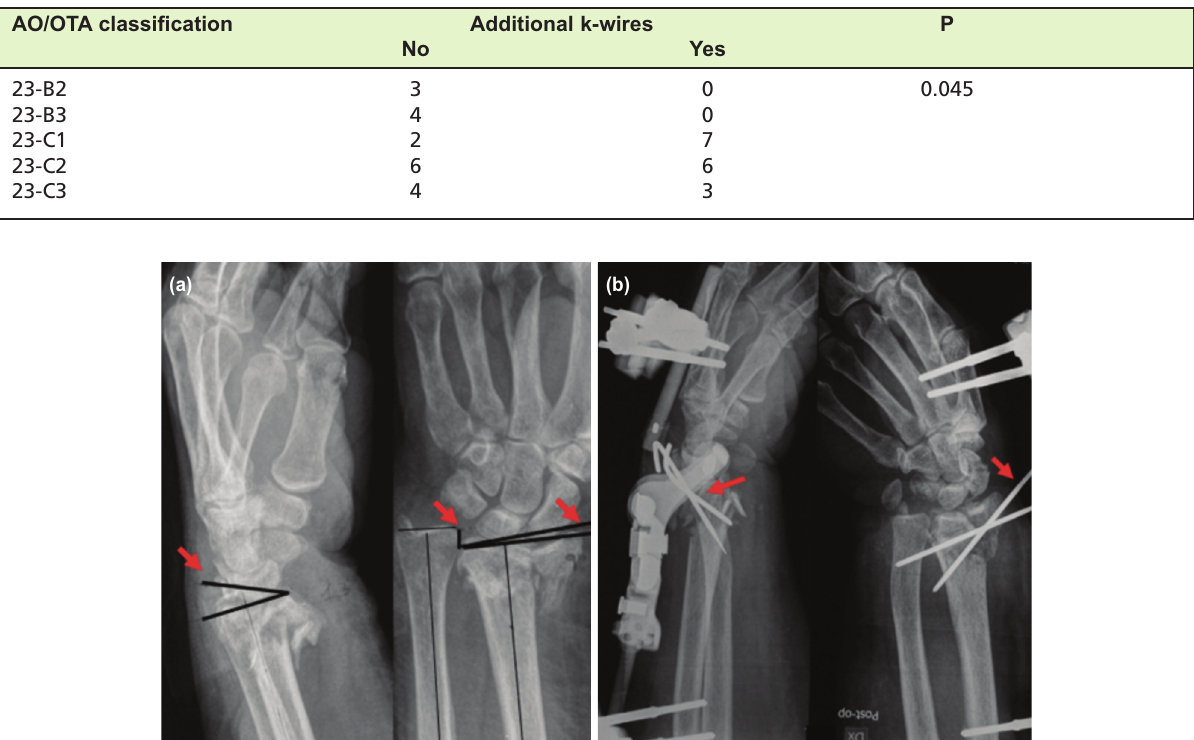
a) Pre-operative radiograph: the arrows showing angles for calculation of pre-operative radiological parameters. (b) Post- Fig. 1: operative radiograph: the arrows showing use of K-wires to complement fracture